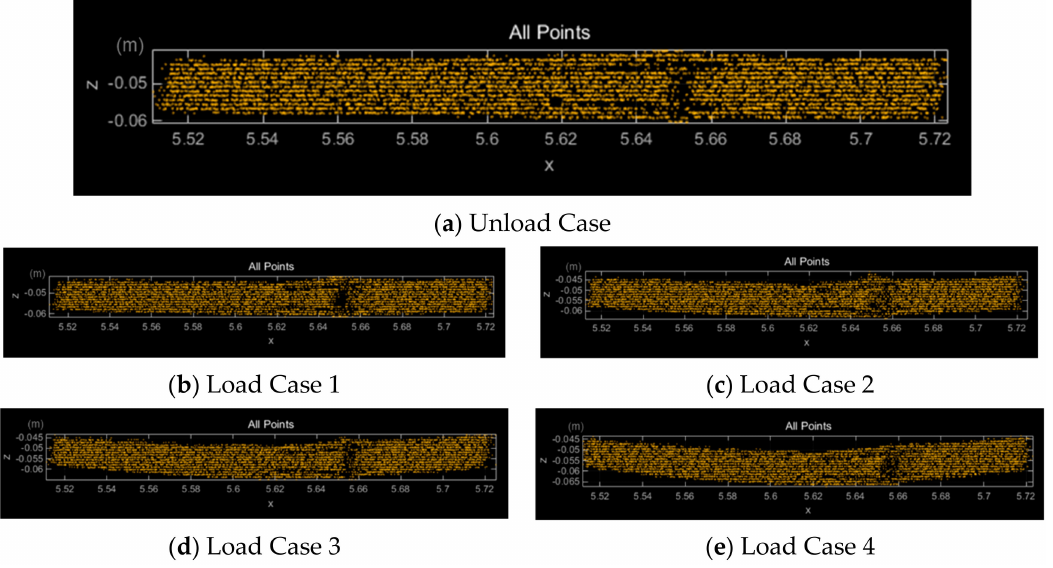
Figure 5. Scanning data of a specimen (10 mm) for each load.